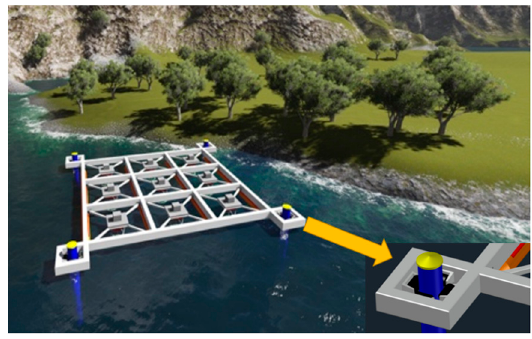
Figure 2. Platform